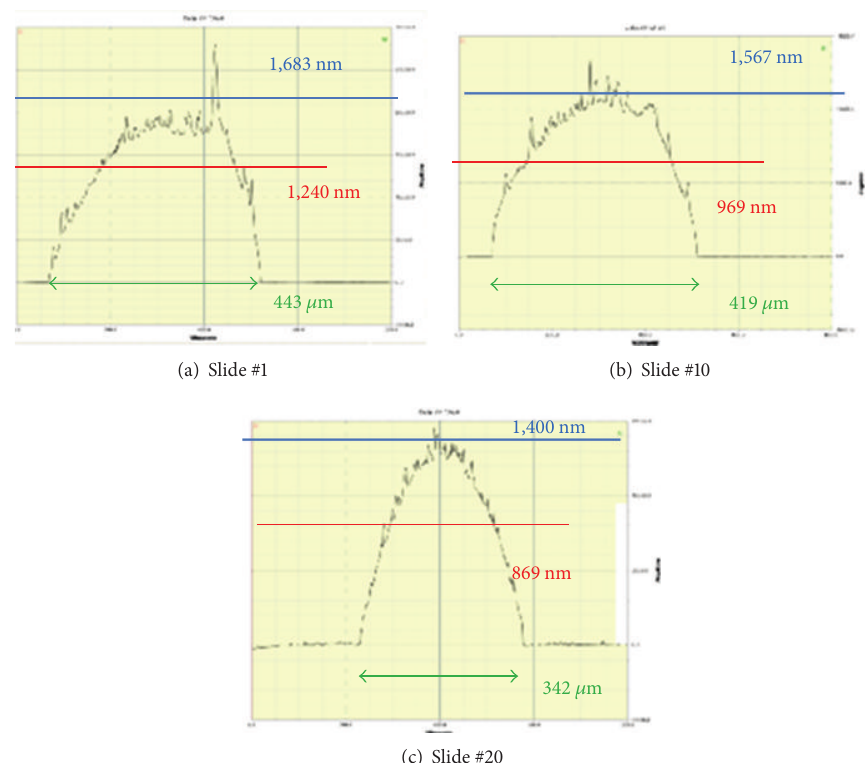
Figure 3: Representative results of profiles from 𝛼 -step measurement. top: max height, middle: average height, and bottom: average